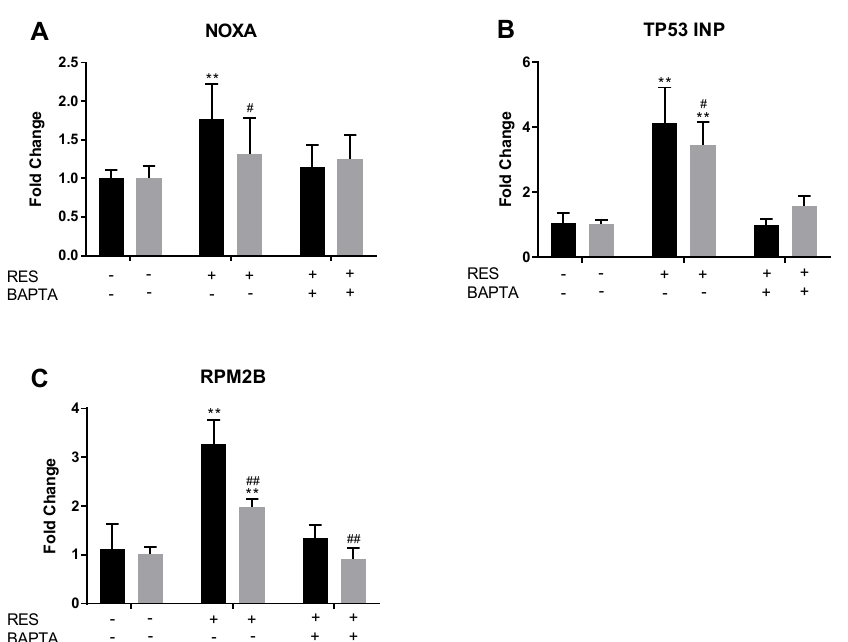
Figure 9. RES-induced upregulation of pro-apoptotic genes is dependent on an increase in [Ca 2+ ] i and, to a lesser extent, p53. MDA-MB-231 cells were treated with p53-targeting siRNA (gray) and non-targeting siRNA (black) for 48 h. Subsequently, where indicated, cells were pretreated for 30 min with 20 μ M BAPTA-AM (indicated by +), followed by treatment with 100 μ M RES (indicated by +) for 6 h. RES induced a calcium-dependent increase in each of these three pro-apoptotic genes, NOXA ( A ), TP53 INP ( B ), and RPM2B ( C ). These data represent three biologic replicates that were each performed in triplicate. ** indicates p < 0.01 compared to the untreated control, # indicates p < 0.05 compared to the non-targeting siRNA control treated with the same treatment, and ## indicates p < 0.01 compared to the non-targeting siRNA control treated with the same treatment.